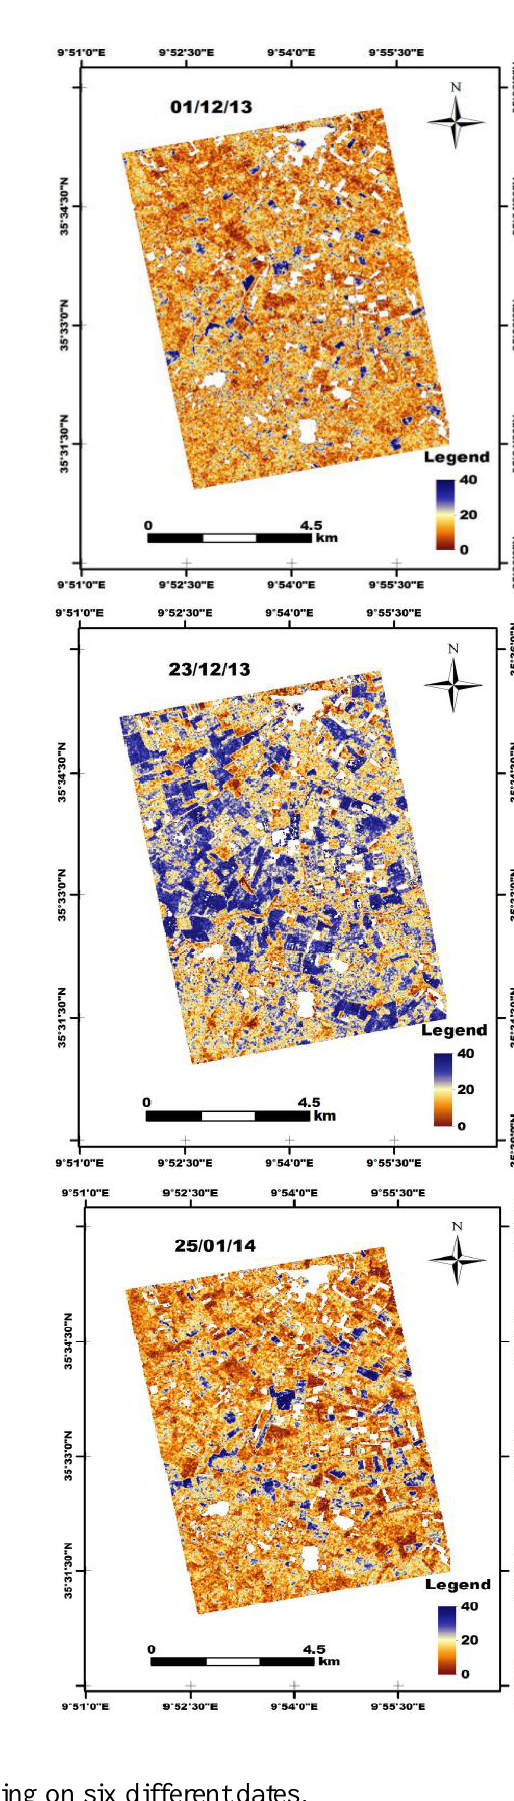
Figure 7. Soil moisture mapping on six different